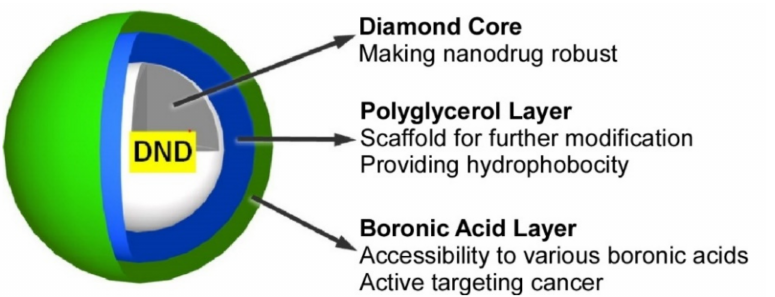
Figure 7. Boronic-acid-functionalized detonation nanodiamonds as an anticancer agent for boron neutron capture therapy. Reprinted with permission from [144]. Copyright 2021, Chemical Society of